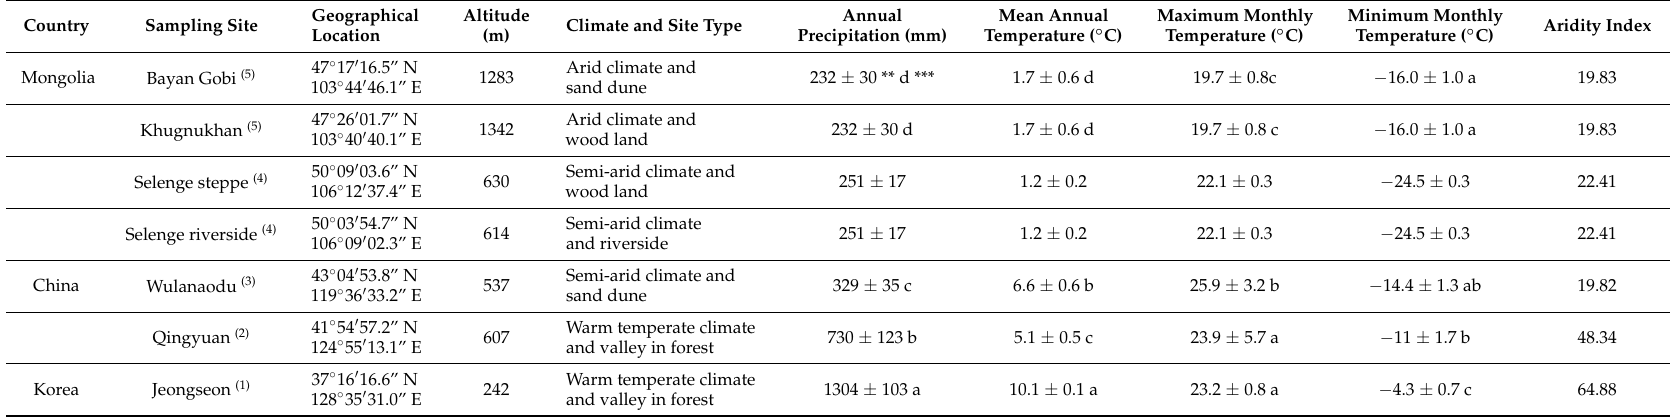
Table 1. Geographical and climatic conditions * of seven sampling sites in Mongolia (Bayang Gobi, BG; Kokunhang, KK; Selenge Steppe, ST; Selenge River, SR), China (Qingyuan, QY; Wulanaodu, WL) and Korea (Jeongseon,